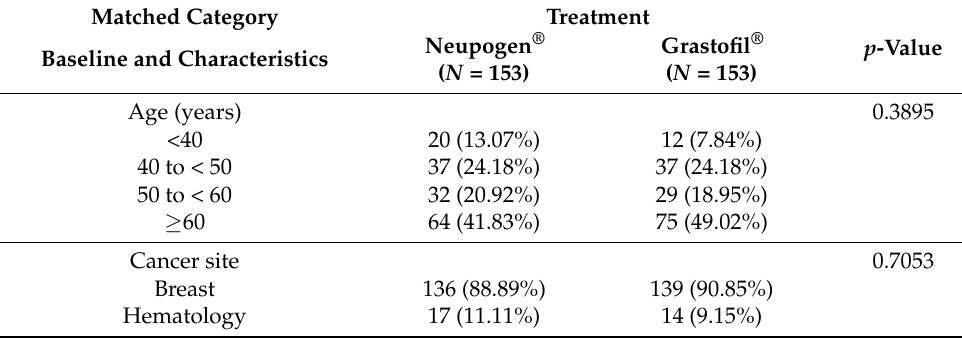
Figure 1. Exclusion criteria to determine cohorts. Table 1. Propensity Score